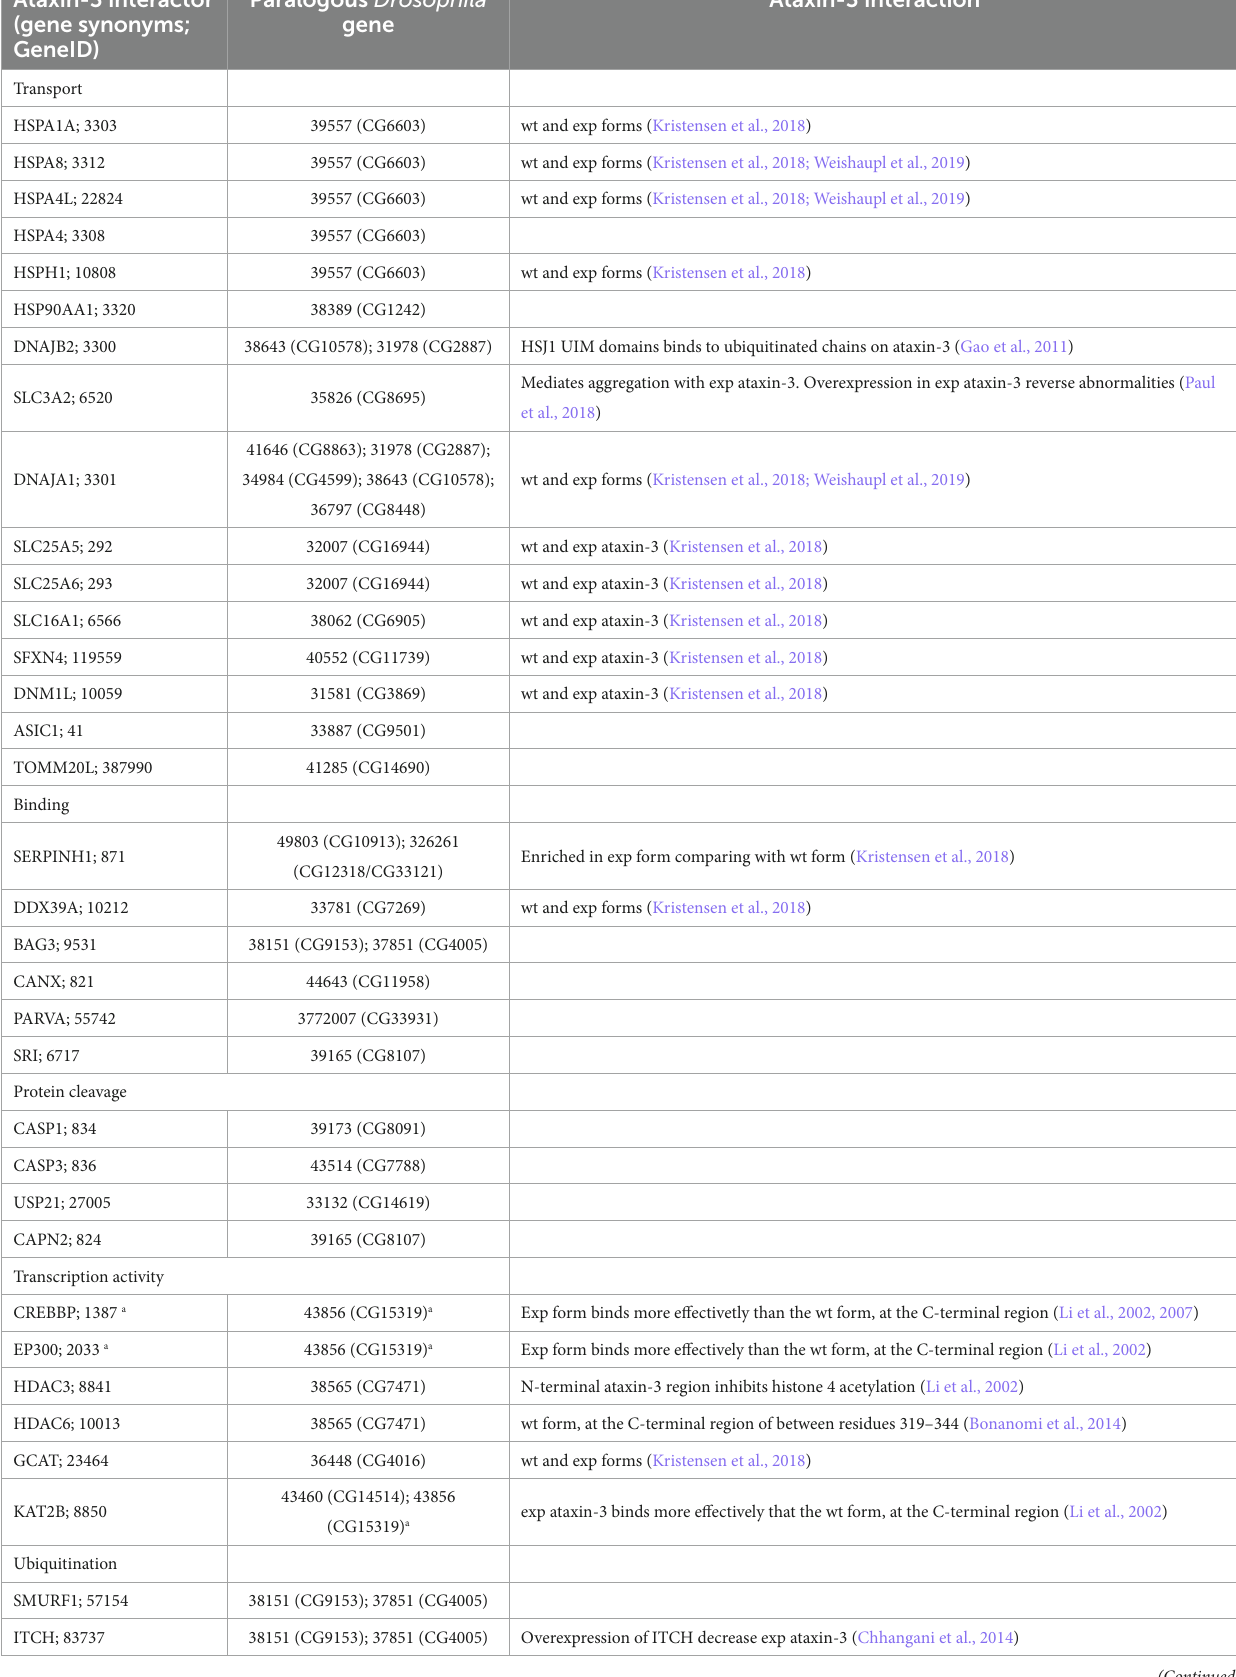
TABLE 1 The Ataxin-3 interactors here analyzed, presenting Drosophila paralog genes reported as modifiers of polyQ toxicity in mutant flies. Ataxin-3 interactor Paralogous Drosophila (gene synonyms;